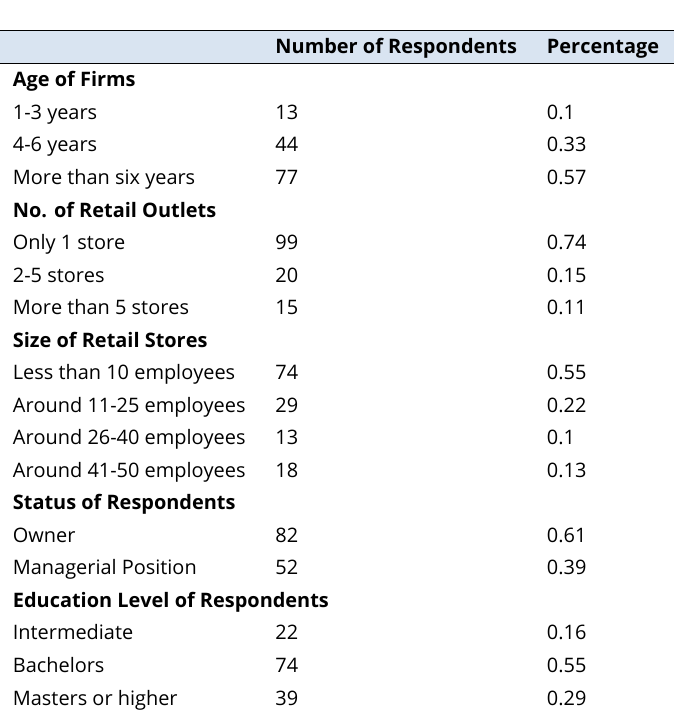
Demographic Characteristics